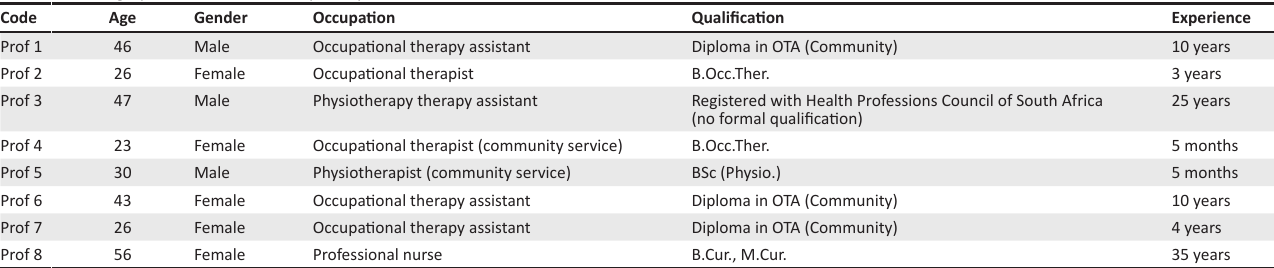
TABLE 1: Demographic characteristics of